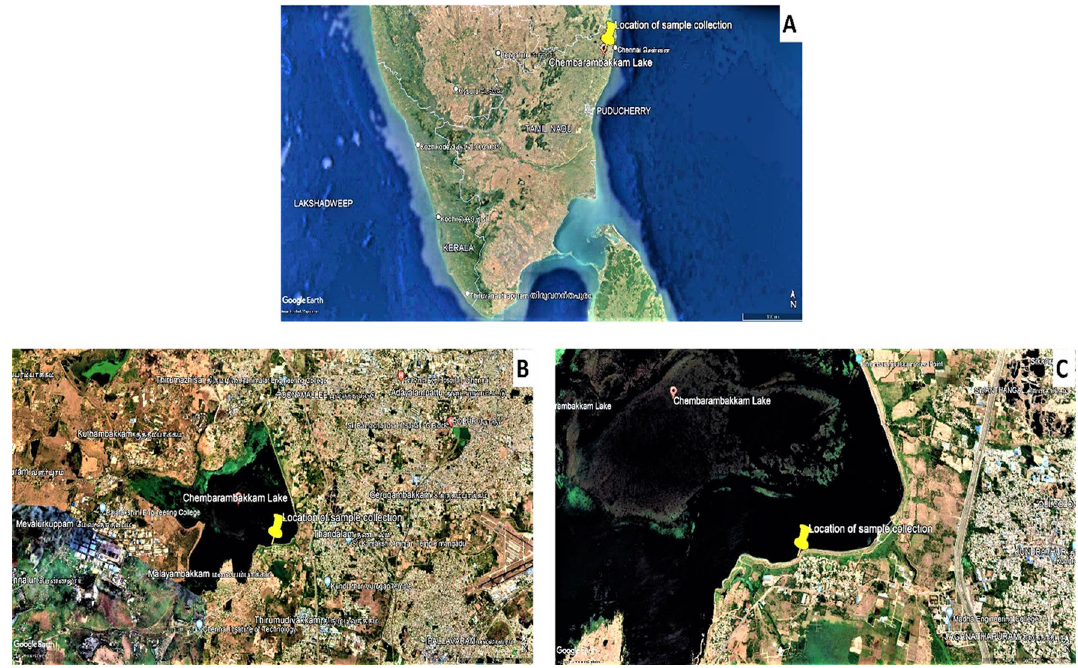
Figure 1. ( A ) Topogeographical image showing Southern part of India, in which the sample collection site located at the Top of the Northeastern Tamil Nadu, near Chennai City; ( B ) The image showing a clear view of the outline of the Chembarambakkam Lake; ( C ) The image showing the exact location of water sample collection (Retrieved from Google Earth Pro 7.3.4.8573 (https:// google- earth- pro. updat estar. com/